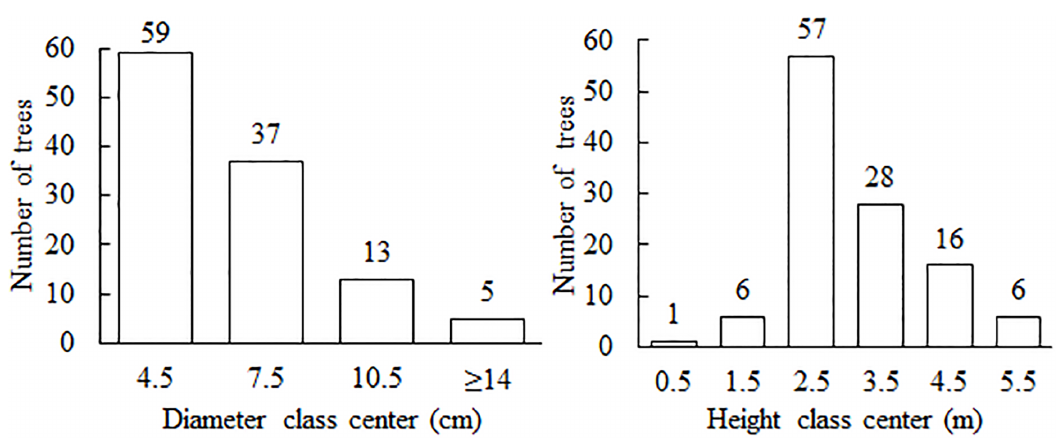
Fig 2. Diameter and height distributions of trees sampled outside Brası´lia Botanical Garden in Brazil used to develop allometric biomass